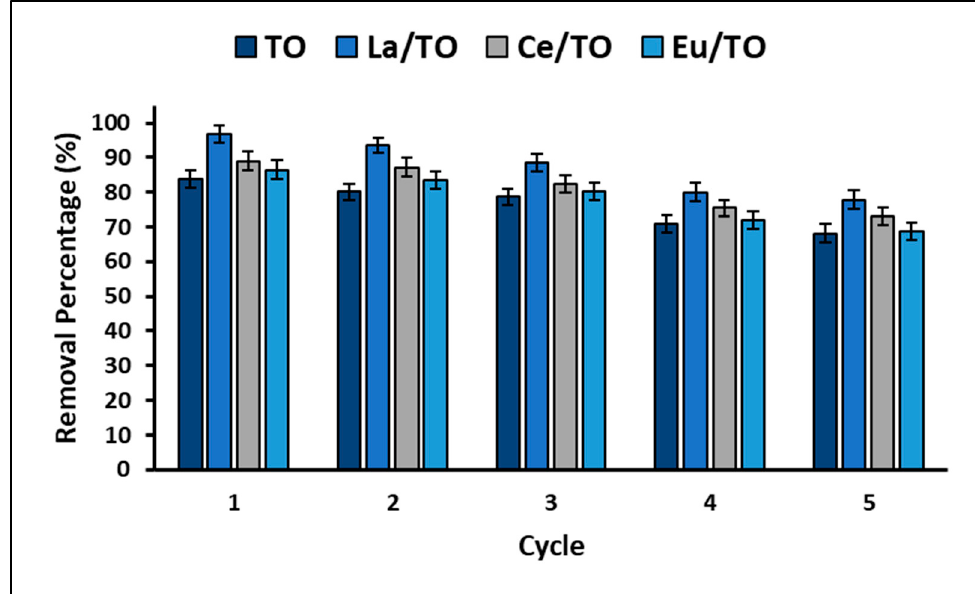
Figure 14. Nanoparticle reuse experiment.